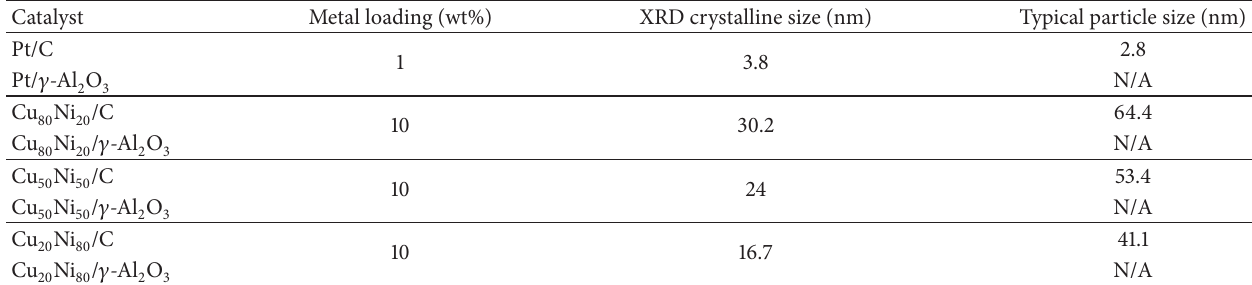
Table 1: Catalyst physical